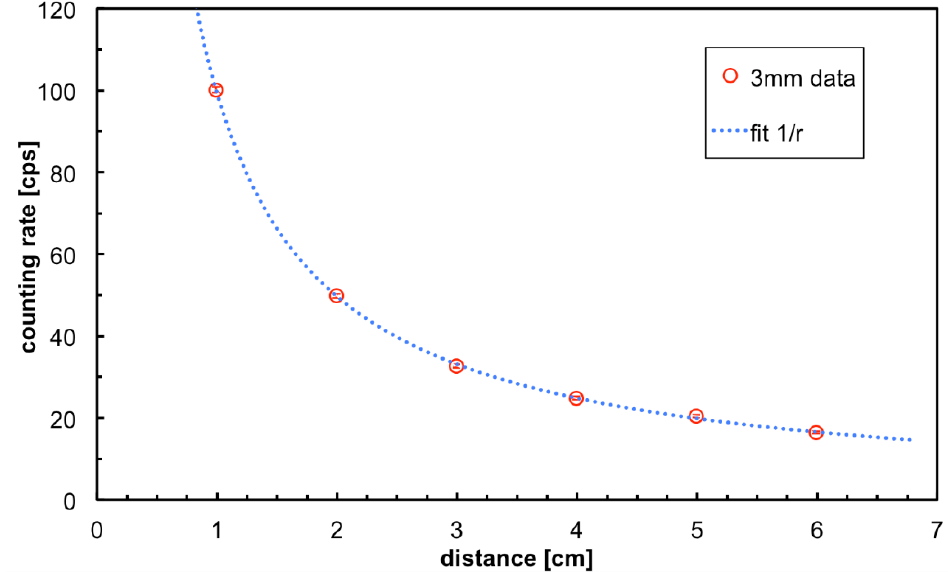
Figure 11. The observed count rate as function of the distance between the point-like 22 Na source and the 3 mm diameter fiber. Additionally shown is a 1/r fit. and the 3 mm diameter fiber. Additionally shown is a 1/r